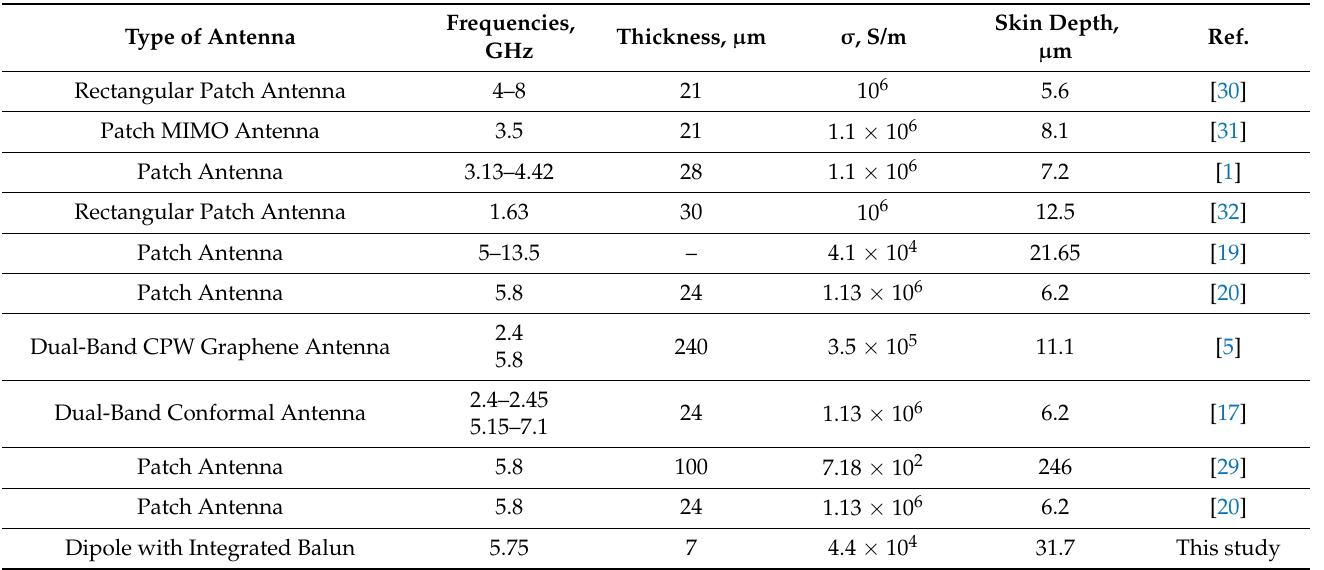
Table 1. Comparison of antenna parameters with calculated from conductivity σ the value of skin